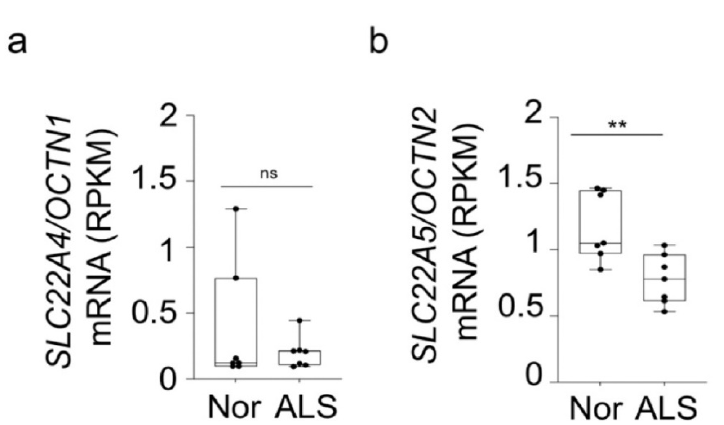
Figure A1. Motor neuronal expression of carnitine transporter is altered in the spinal cord of human ALS patients. ( a ) SLC22A4 is decreased in motor neurons of the spinal cord of human ALS patients ( n = 7) compared to normal subjects (Nor) ( n = 7), but it is not significant. ( b ) SLC22A5 is significantly decreased in motor neurons of the spinal cord of human ALS patients ( n = 7) compared to normal subjects (Nor) ( n = 7). ** Significantly different at p < 0.01. This data was retrieved and analyzed from previously publishes data (GSE76220_ALS_LCM_MPR_gene_expression [23]. Briefly, laser capture microdissection (LCM) method was used to collect motor neuron-specific RNA and pooled motor neuronal RNA was undergone high-throughput RNA sequencing. The relative expression of transcript was presented as reads per kilobase of transcript per million mapped reads (RPKM).